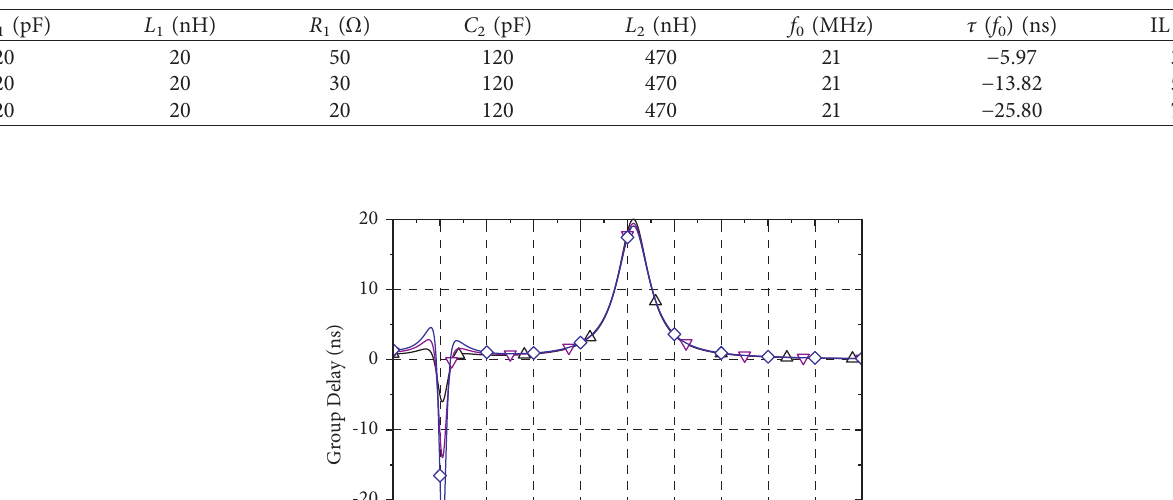
Table 5: Element values of the band-pass negative group delay circuit with different R